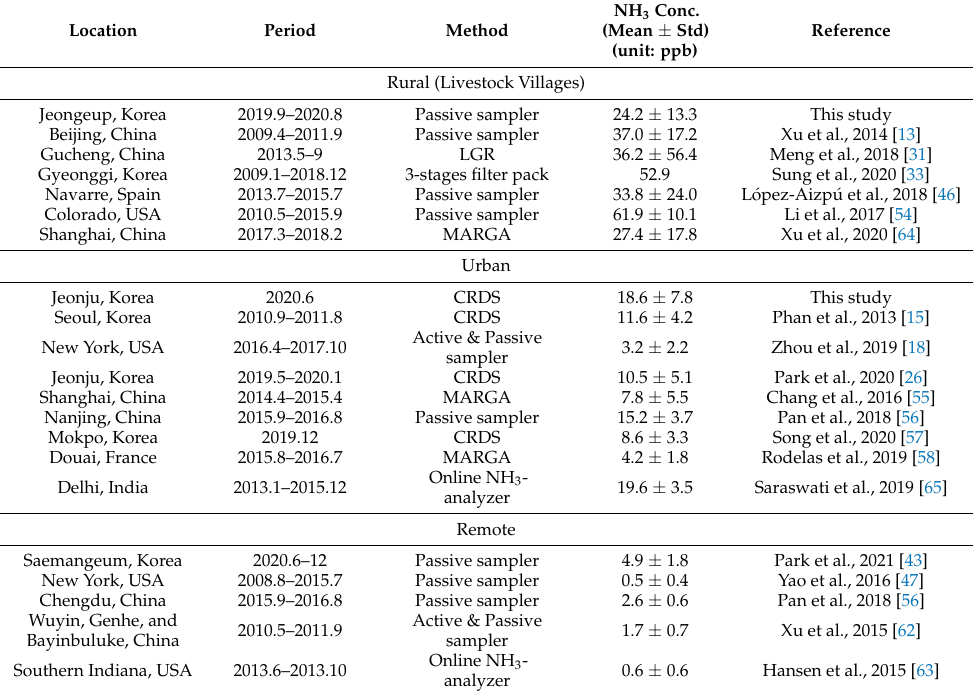
Table 2. Summary of atmospheric NH 3 concentrations in different environments. LGR: Logic gates as repeater; CRDS: Cavity ring-down spectroscopy; and MARGA: Monitor for aerosols and gases in ambient